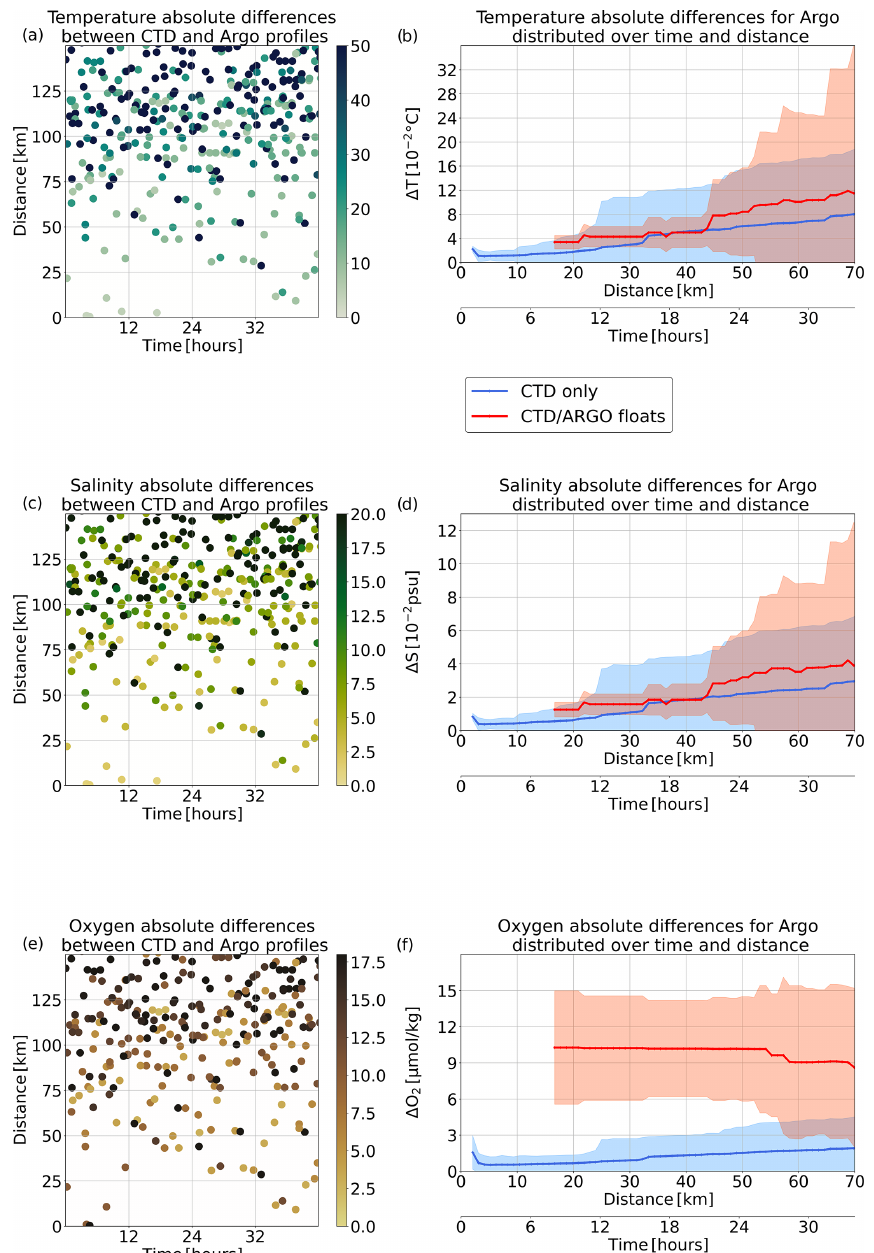
Figure 19. (a) Absolute temperature differences between CTD/Argo float pairs of profiles on isopycnal levels, averaged and vertically distributed in time and distance. Each pair is composed of one CTD and one Argo float profile. (b) Temperature differences as a function of time and distance for pairs of profiles. Differences are shown in blue for pairs of CTD-only profiles and in red for pairs composed of one CTD and one Argo float profile. The middle line of panels is the same as above but for absolute salinity differences. The bottom line of panels corresponds to absolute oxygen